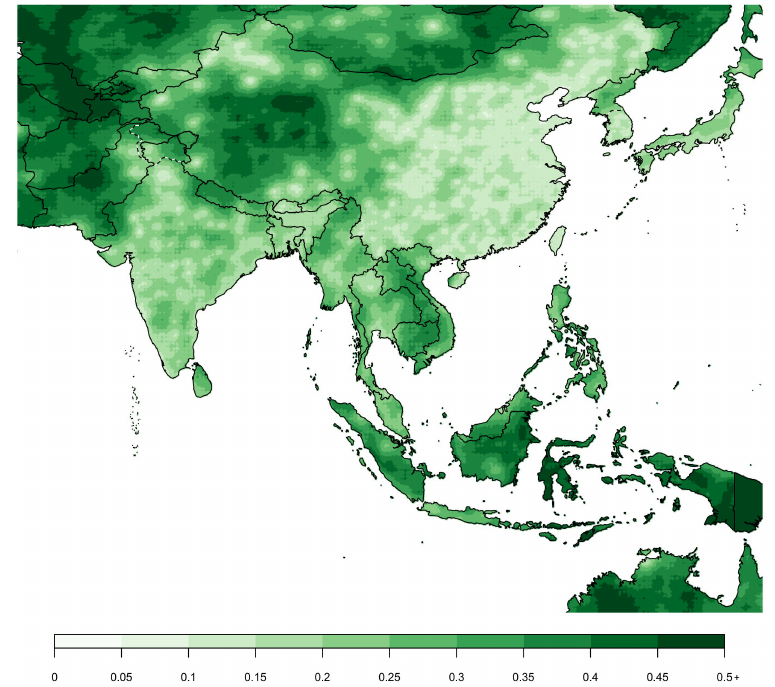
Figure 6. Uncertainty associated with estimated annual average concentrations of PM 2.5 in the Eastern/South-Eastern Asia and Central/Southern Asia SDG regions for 2016. Uncertainty is repre- sented by the coefficient of variation (mean/standard